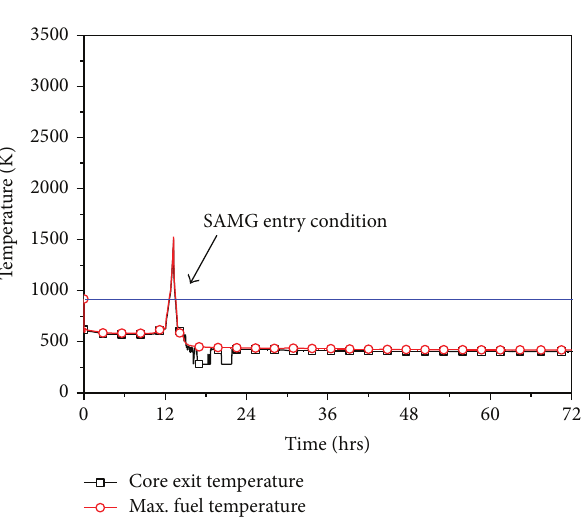
Figure 10: Secondary injection core exit and fuel